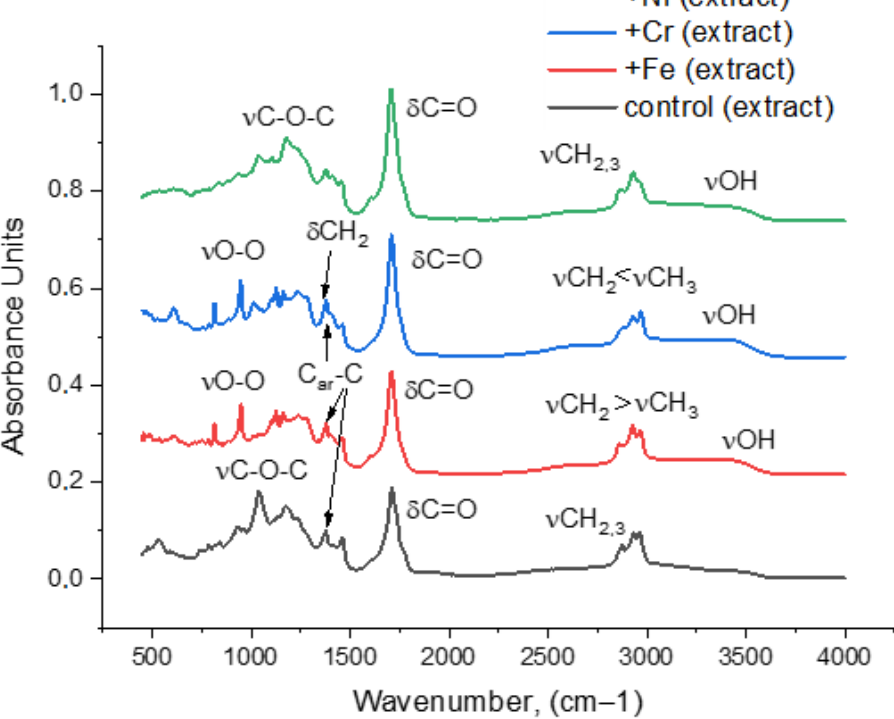
Figure 5. FT-IR spectra of catalytic and non-catalytic oxidation products adsorbed in silica.